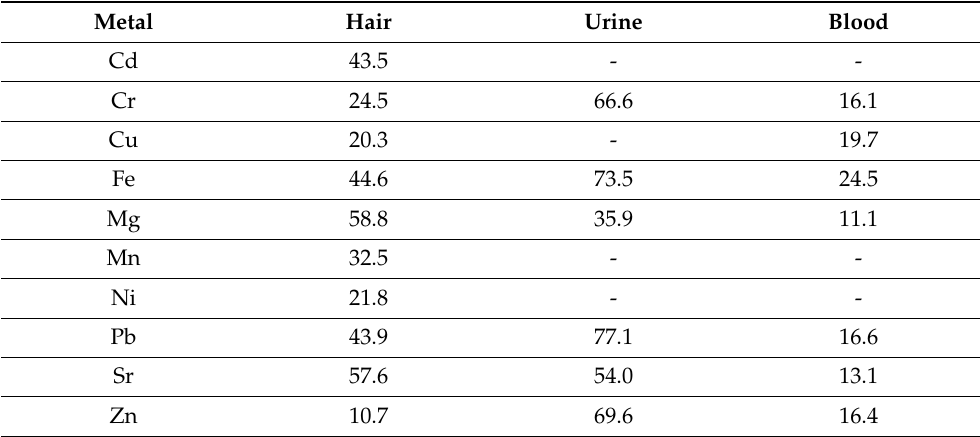
Table 4. The variational volatility of observation series of the metal’s concentration in different biological substrates,